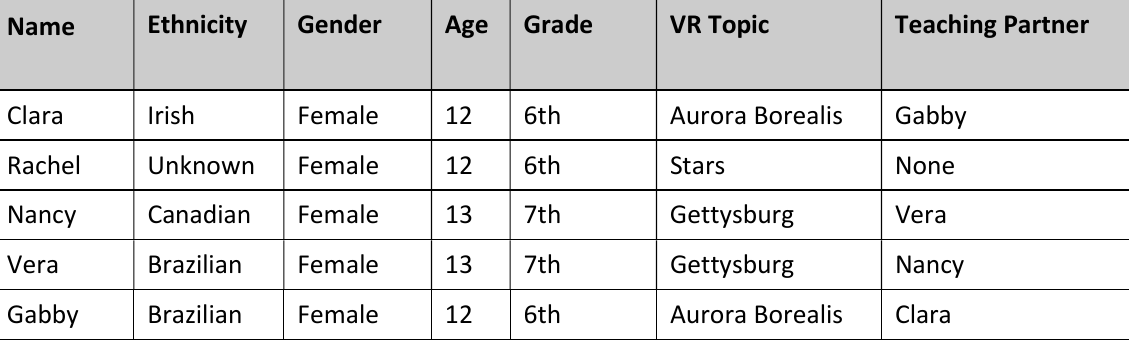
Table 1: Participant background